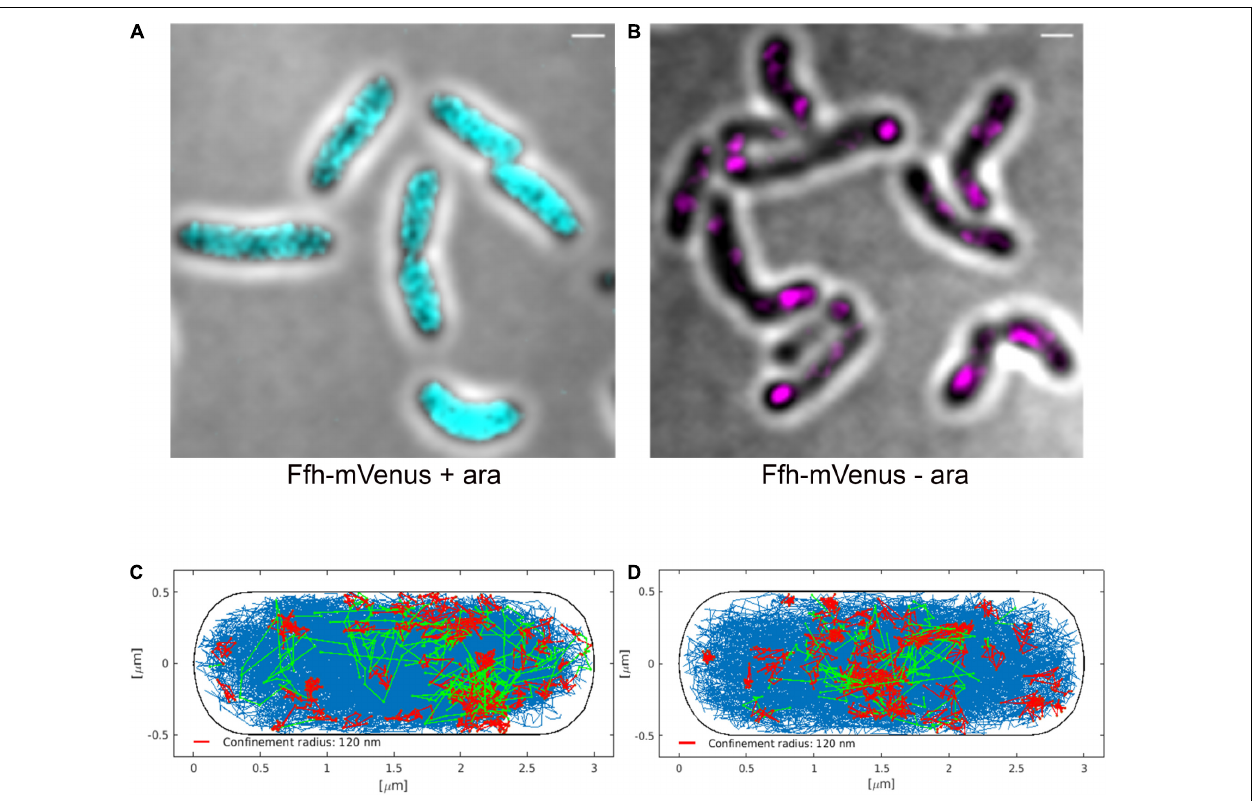
FIGURE 8 | Averaged 3D-SIM image stack projection and confinement maps of Ffh-sfGFP in cells expressing FtsY under control of the arabinose promoter, false-colored in cyan (A) , or in cells after depletion of FtsY due to growth in the absence of arabinose, false-colored in magenta (B) . Scale bar 1 µ m. (C) Confinement map of Ffh-mVenus tracks in the presence of arabinose (FtsY), or (D) in the absence of arabinose/FtsY. Blue track non-confined motion, red tracks confined motion of at least 9 steps within a radius of 120 nm, green tracks transitions between confined and free motion, projected into a standardized cell of 3 × 1 µ m size.